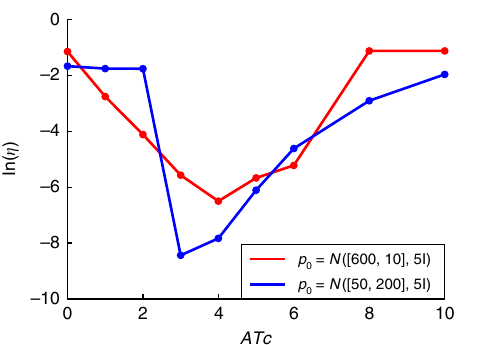
Fig. 5 Convergence rates toward the equilibrium distribution. η in Eq. (8) in units of h (cid:2) 1 is plotted for different initial conditions (in logarithmic scale). The parameter region leading to bimodal distributions corresponds with the slowest convergence